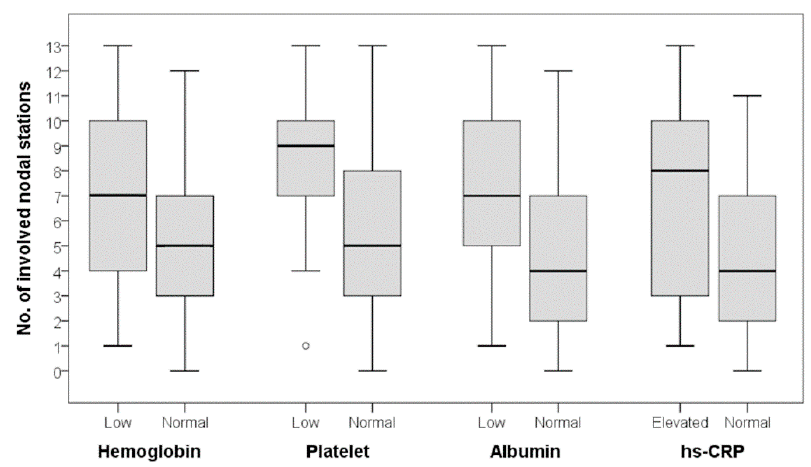
Figure 1. Number of involved nodal stations according to laboratory findings. There was no statistically significant difference for hemoglobin, but significant differences were observed for platelet, albumin, and high-sensitivity C-reactive protein (hs-CRP) levels (Mann-Whitney U test; hemoglobin, p = 0.186; platelet, p = 0.032; albumin, p = 0.027; hs-CRP, p = 0.025).